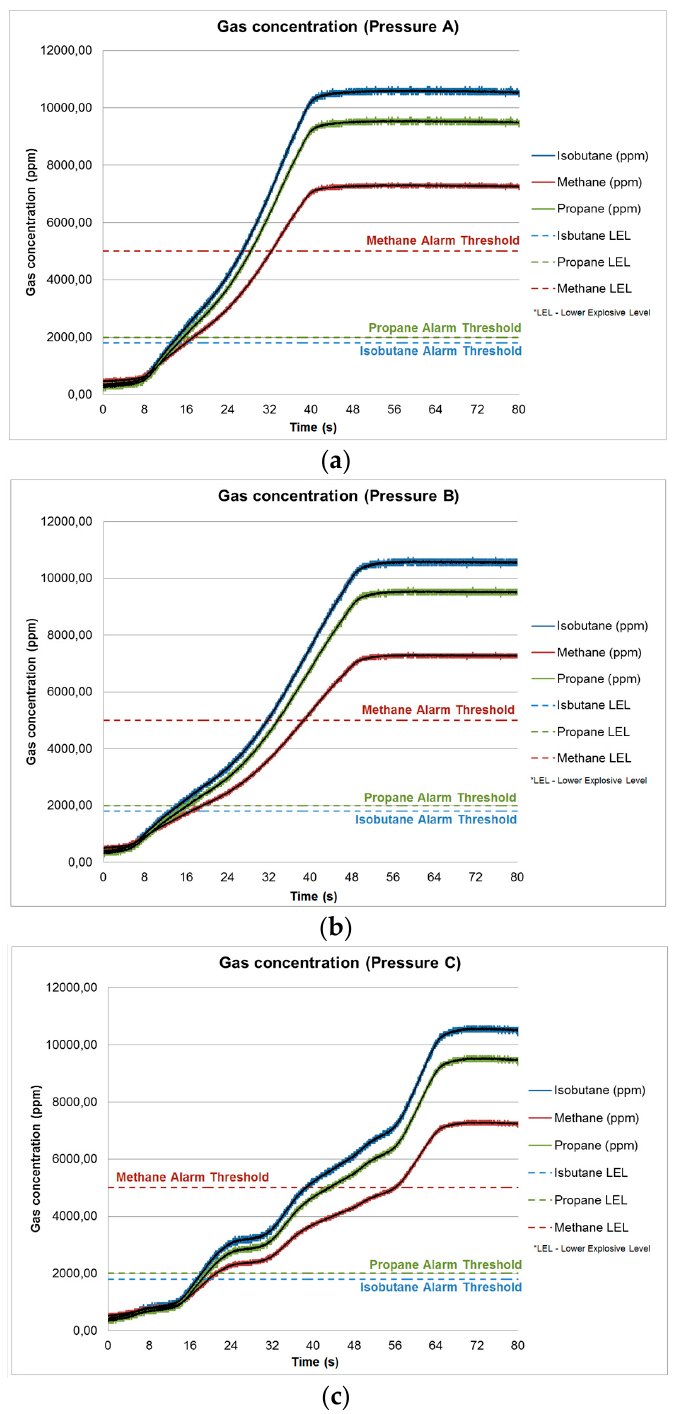
Figure 11. Time response of gas detector measurements in three cases. ( a ) Higher pressure, ( b ) Middle pressure and ( c ) Lower pressure.